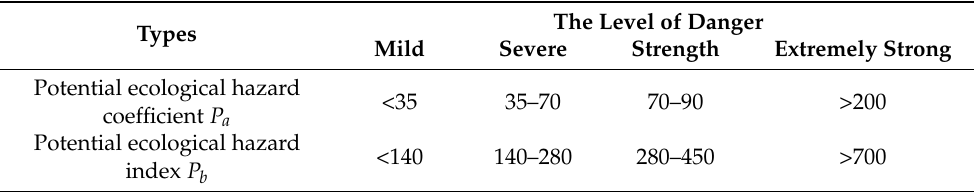
Table 2. Potential ecological risk hazard classification